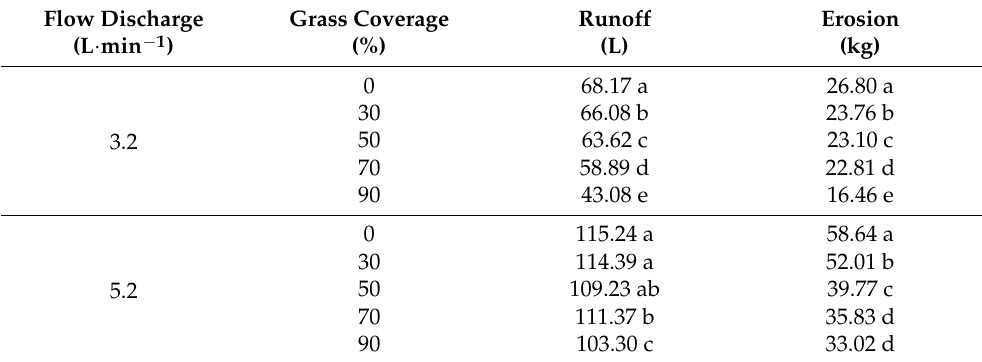
Mean values of the same letter in the same columns are not significantly different at p = 0.05 level using the least significant difference method.